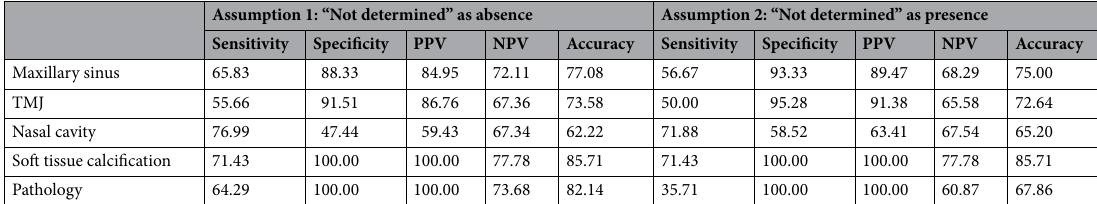
Table 6. Sensitivity, specificity, positive predictive value (PPV), negative predictive value (NPV), and accuracy of 2D combination radiography (PANO + LAT + PA) based on the gold standards by CBCT.